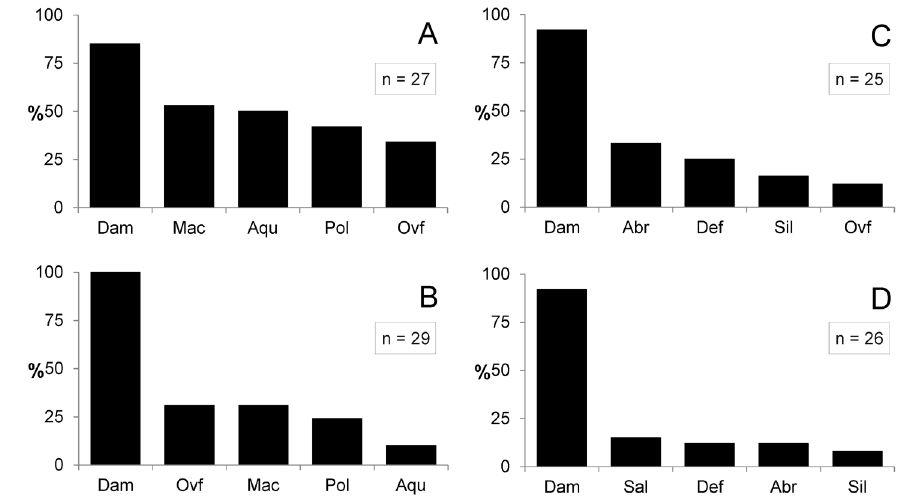
FIGURE 3 | List of main impacts mentioned in A. Area 1, B. Area 2, C. Area 3, and D. Area 4, according to fishers from the final portion of the Sub-Middle and Lower São Francisco. Dam: dams; Mac: macrophytes; Aqu: aquaculture; Pol: pollution; Ovf: overfishing; Abr: absence of rain; Def: deforestation; Sil: silting; Salt: